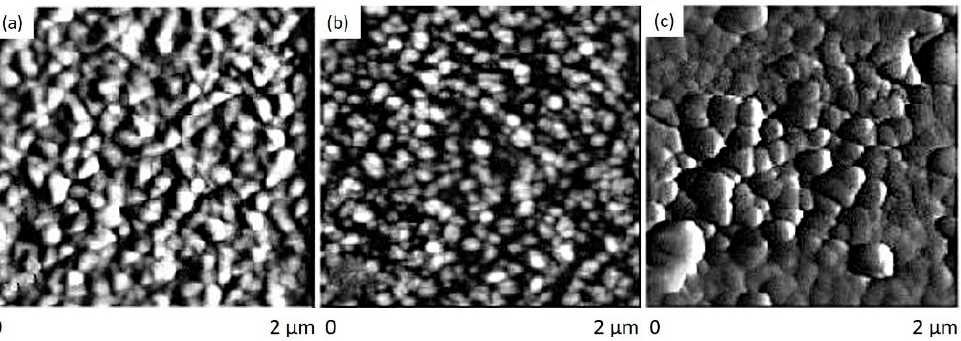
Figure 7. Atomic force microscope images of the ZnGa 2 O 4 films grown on ( a ) Si(100), ( b ) Al 2 O 3 (0001) and ( c ) MgO(100) substrates at substrate temperature of 550 °C and oxygen pressure of 100 mTorr [80] (with copyright permission from Elsevier, 2020).